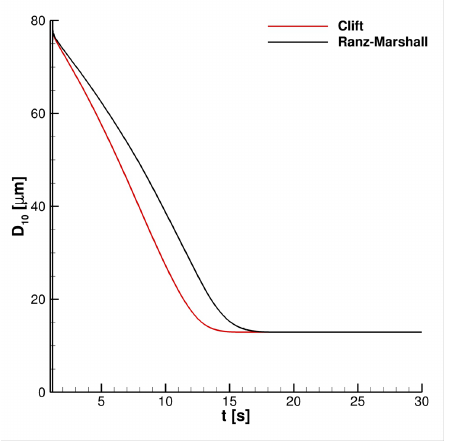
Figure 8. D10 time-history with different Nu/Sh